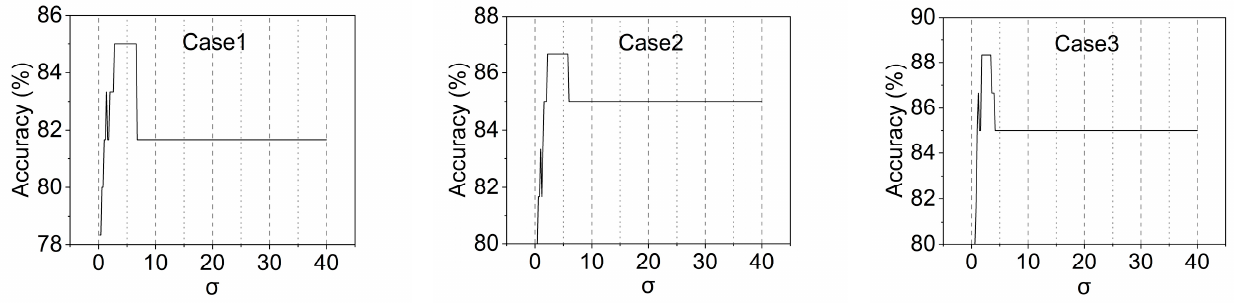
Figure 15. Filtering performance with different σ values.